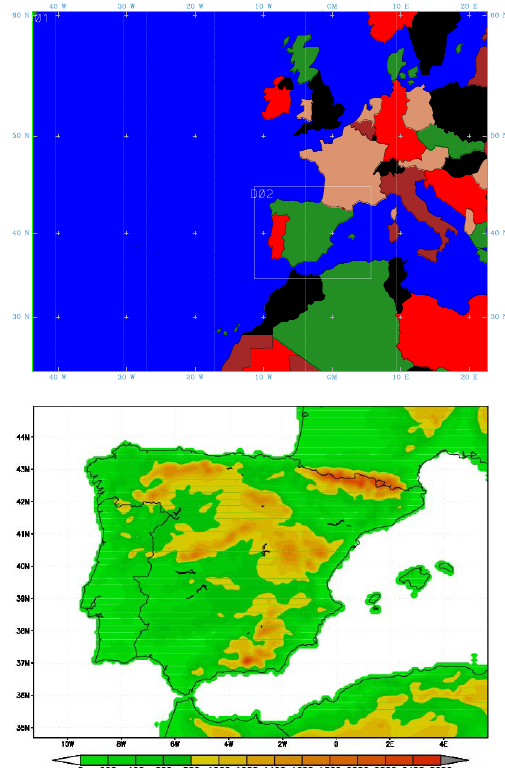
Fig. 1. (a) Geographic coverage of the two domains (coarse and fine) of the MM5 short-range ensemble simulations. (b) Fine do- main corresponding with the Iberian Peninsula with the orography of the model